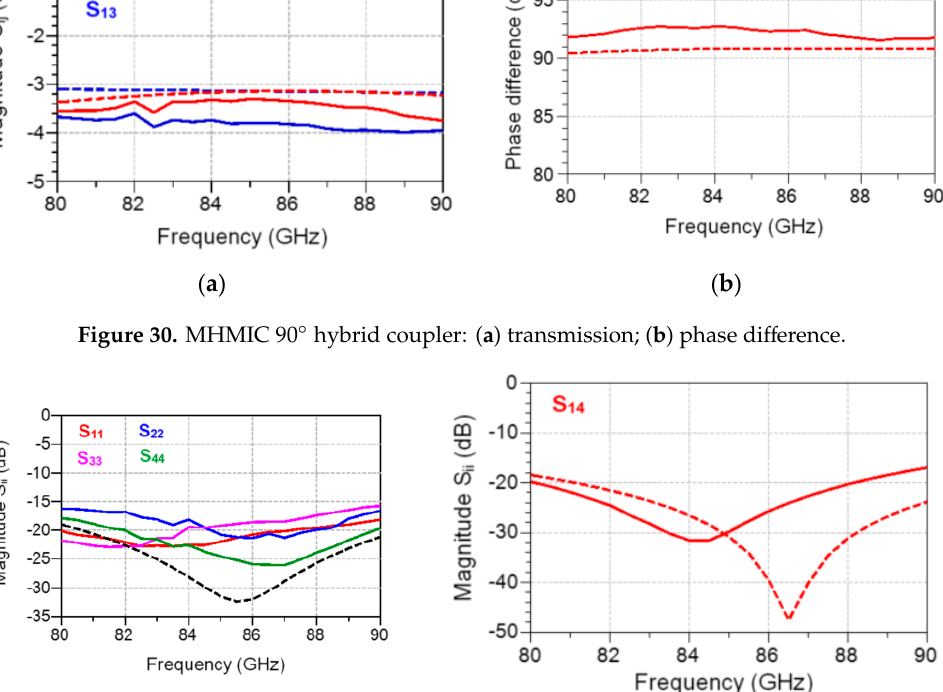
Figure 30. MHMIC 90° hybrid coupler: ( a ) transmission; ( b ) phase difference.